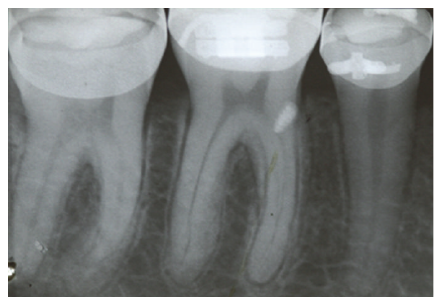
Figure 11: Fractured OI tip that was kept